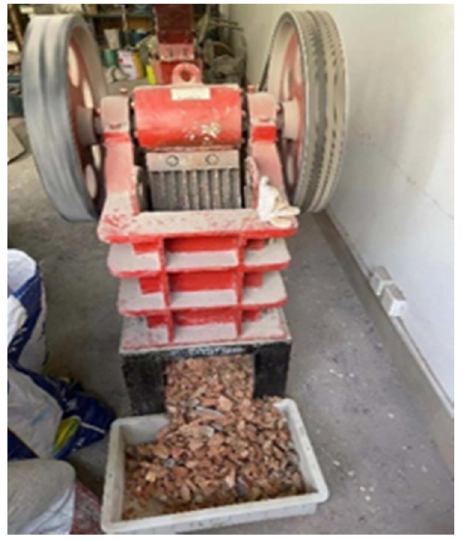
Figure 2: Aggregate crushing.